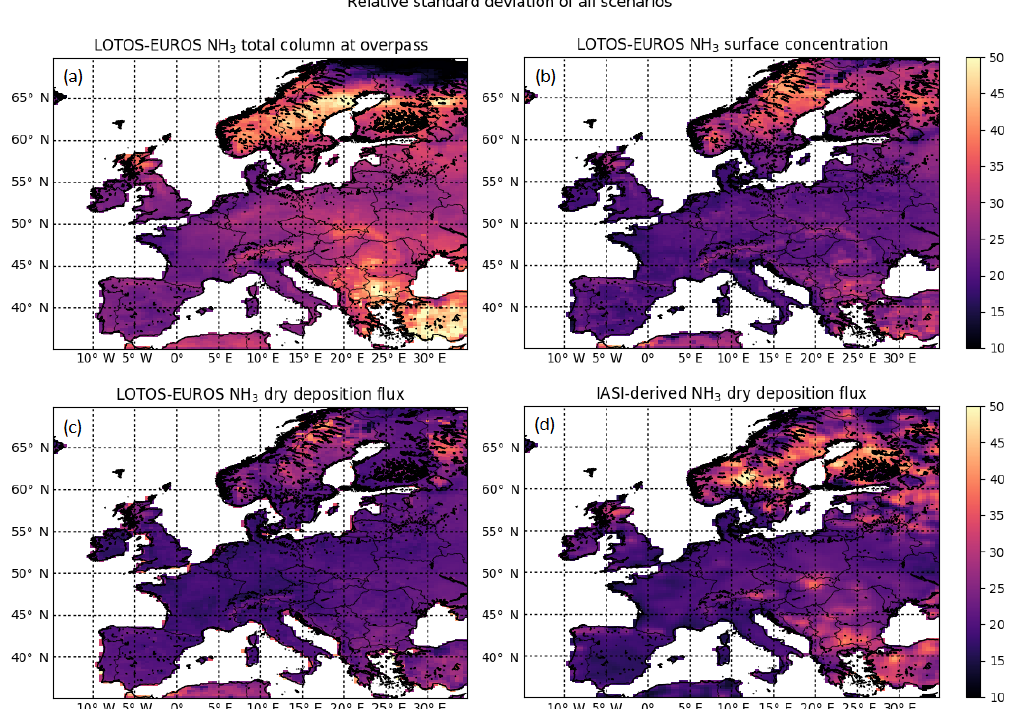
Figure 18. The relative standard deviation (%) of the warm season mean output of all perturbed runs and the associated dry deposition estimate inferred from IASI in 2014. Panel (a) shows the LOTOS-EUROS NH 3 total column concentration at overpass time, (b) the LOTOS- EUROS NH 3 surface concentration, (c) the NH 3 dry deposition flux in LOTOS-EUROS and (d) the resulting IASI-derived NH 3 dry deposi- tion